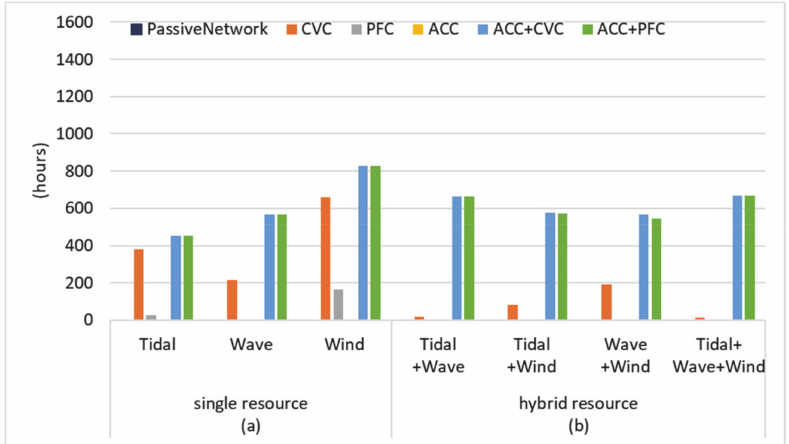
Figure 8. Total hours in the year when the loading of at least one line reaches its full value: ( a ) for single resource networks and ( b ) for hybrid resource